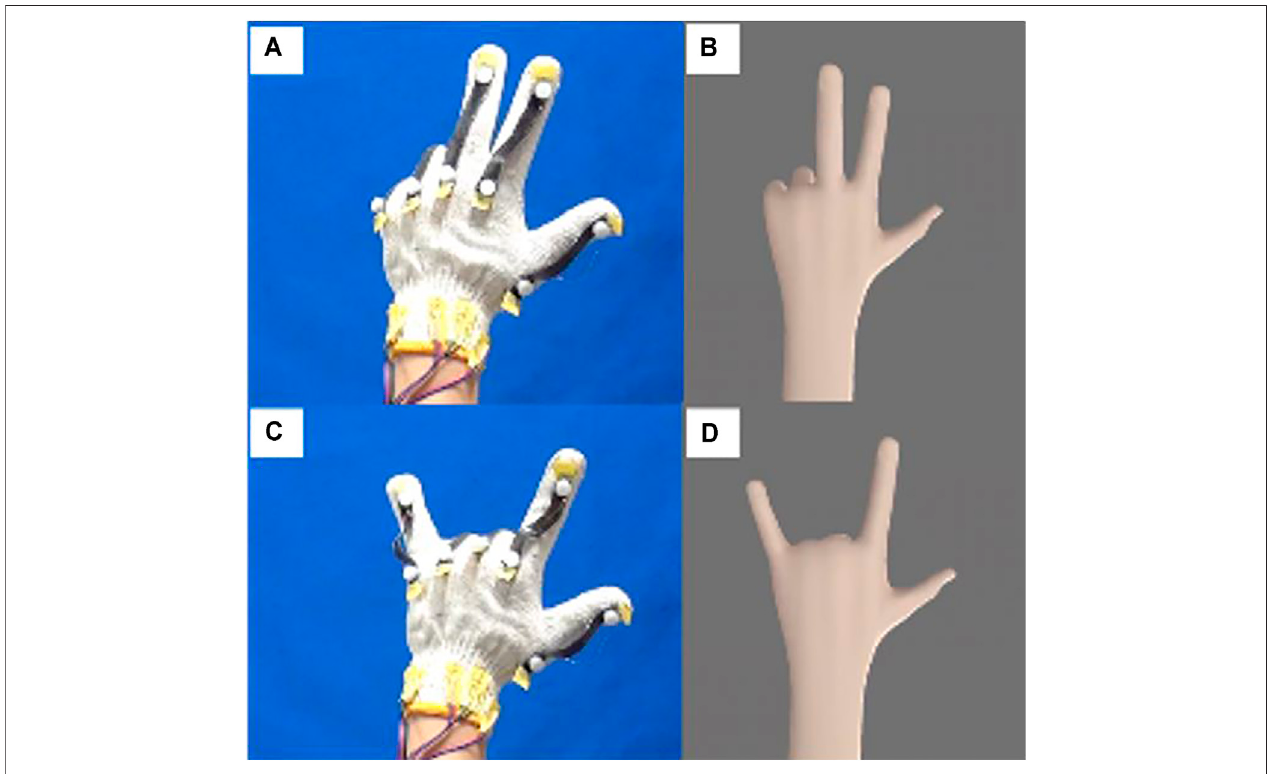
FIGURE 14 | (B and D) Control simulation of a virtual hand using (A and C) a stretchable strain sensor attached to a cotton hand glove.